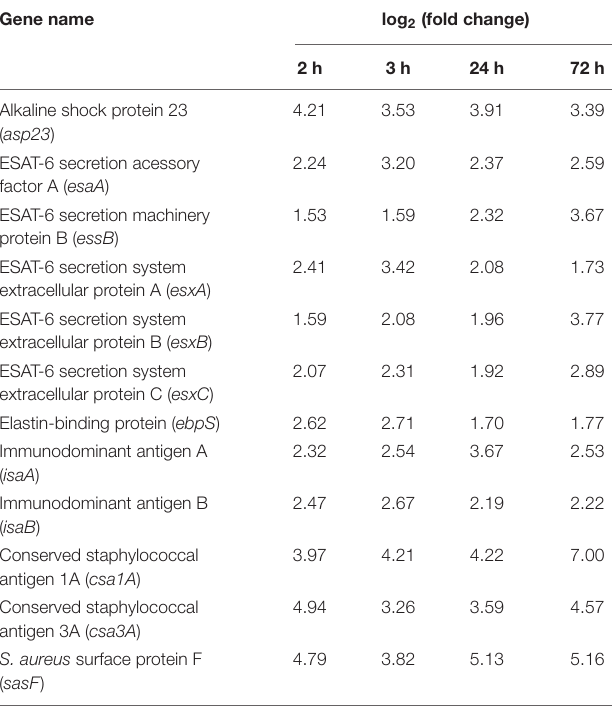
TABLE 1 | Virulence gene expression profile of the 12 factors that were upregulated over the entire course of the infection, when compared with inoculated